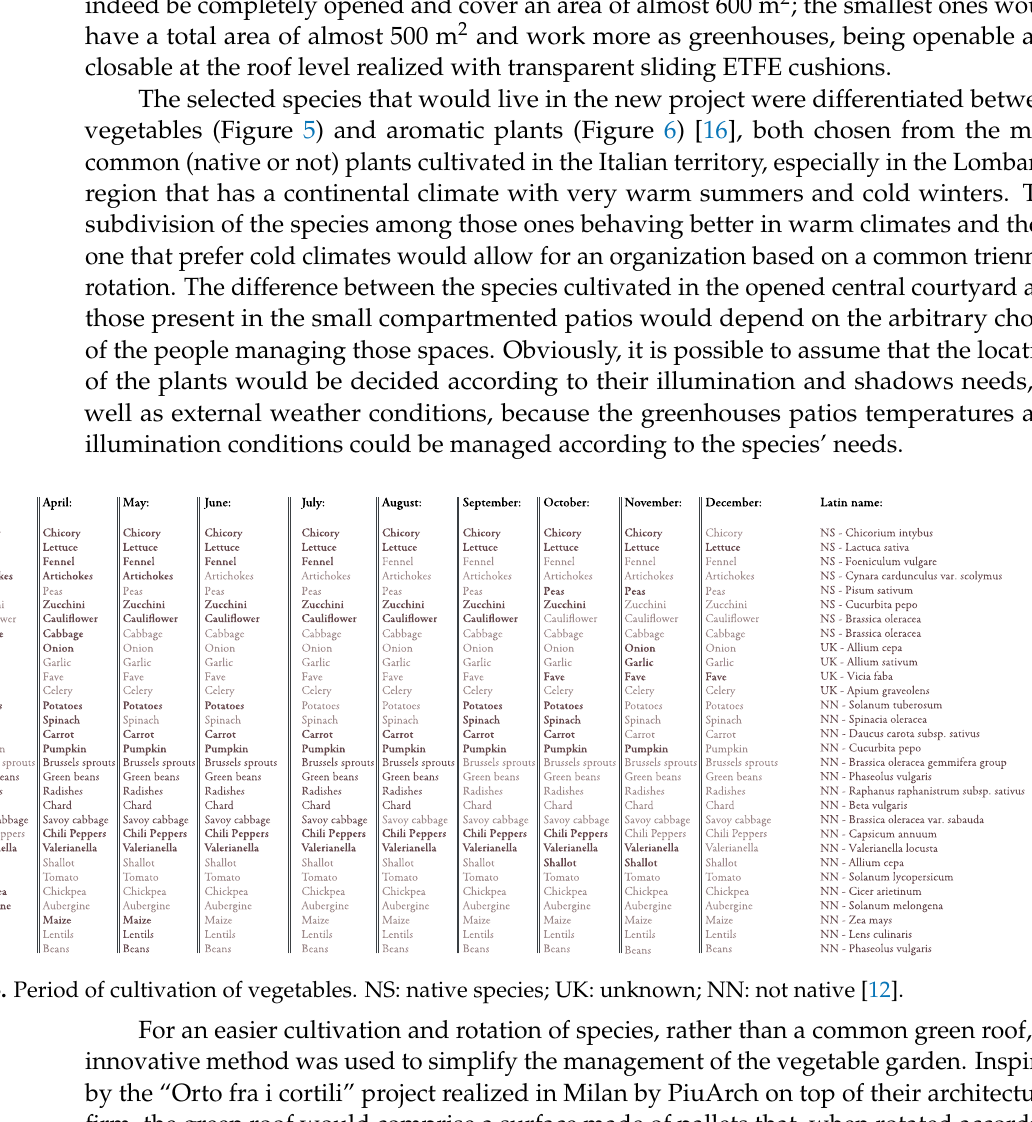
Figure 6. Period of cultivation of aromatic plants. NS: native species; UK: unknown; NN: not native [12].